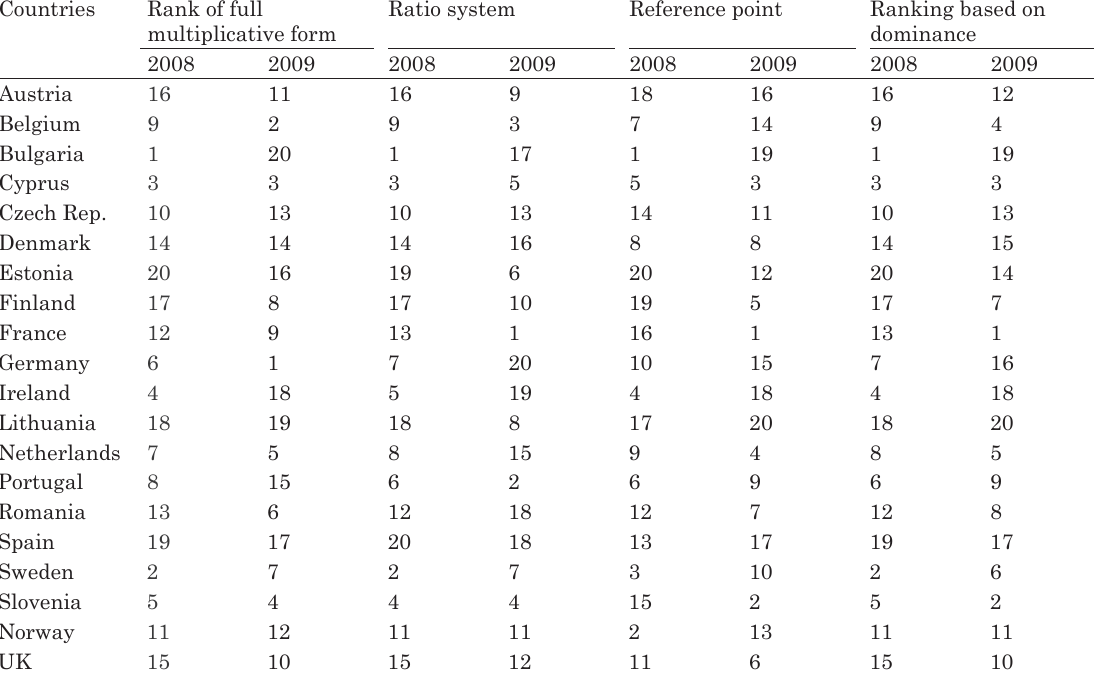
Table A3. The MULTIMOORA method and final ranks of European states